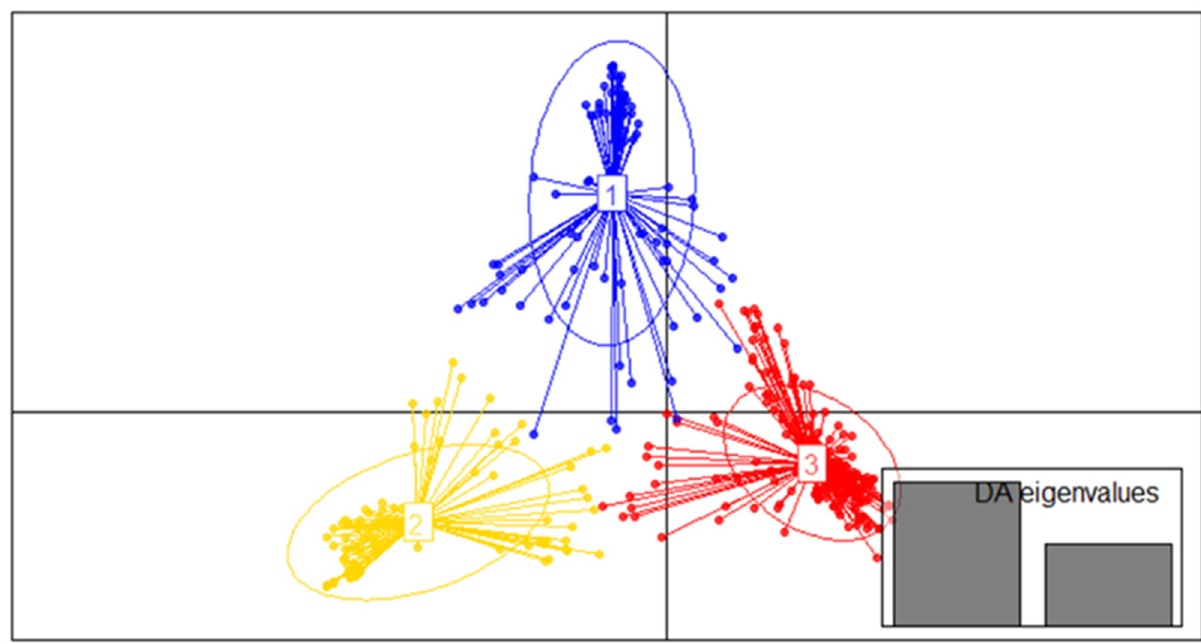
Fig 5. Scattered plot of DAPC, each color represents one cluster. https://doi.org/10.1371/journal.pone.0239122.g005 genotypes drawn from the improved cowpea cultivars representing 76% and 24% of the core collection respectively (Table 4). The core collection named as CC-94 represents 26% of the entire collections. In the core collection all the geographical regions were represented by 20% to 33% of genotypes from the total genotypes collected (Table 4). Fourteen [14], 15, 23, 11, 18